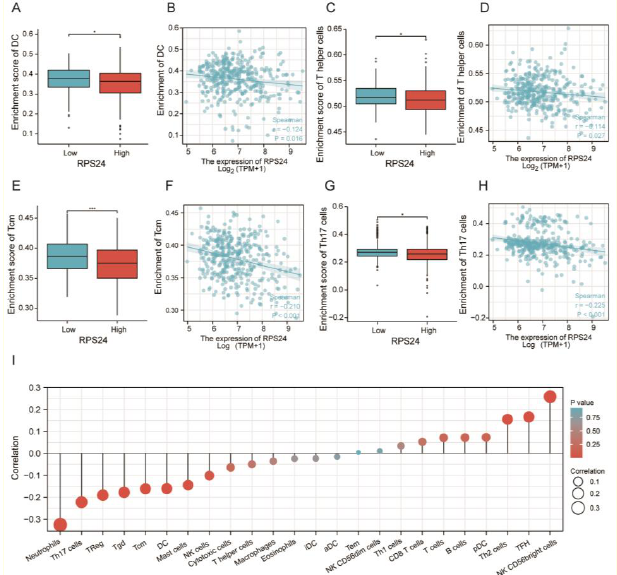
Figure 7. Correlation of RPS24 with immune cell infiltration. ( A – H ) RPS24 expression was negatively correlated with DC, T helper cells, Tcm, and Th17 cells based on the TCGA-LIHC data. ( I ) The lollipop showed that RPS24 was correlated with several infiltrated immune cells. Abbreviations: DC, dendritic cell; Tem, effective memory T-cell. * p < 0.05; *** p < 0.001.